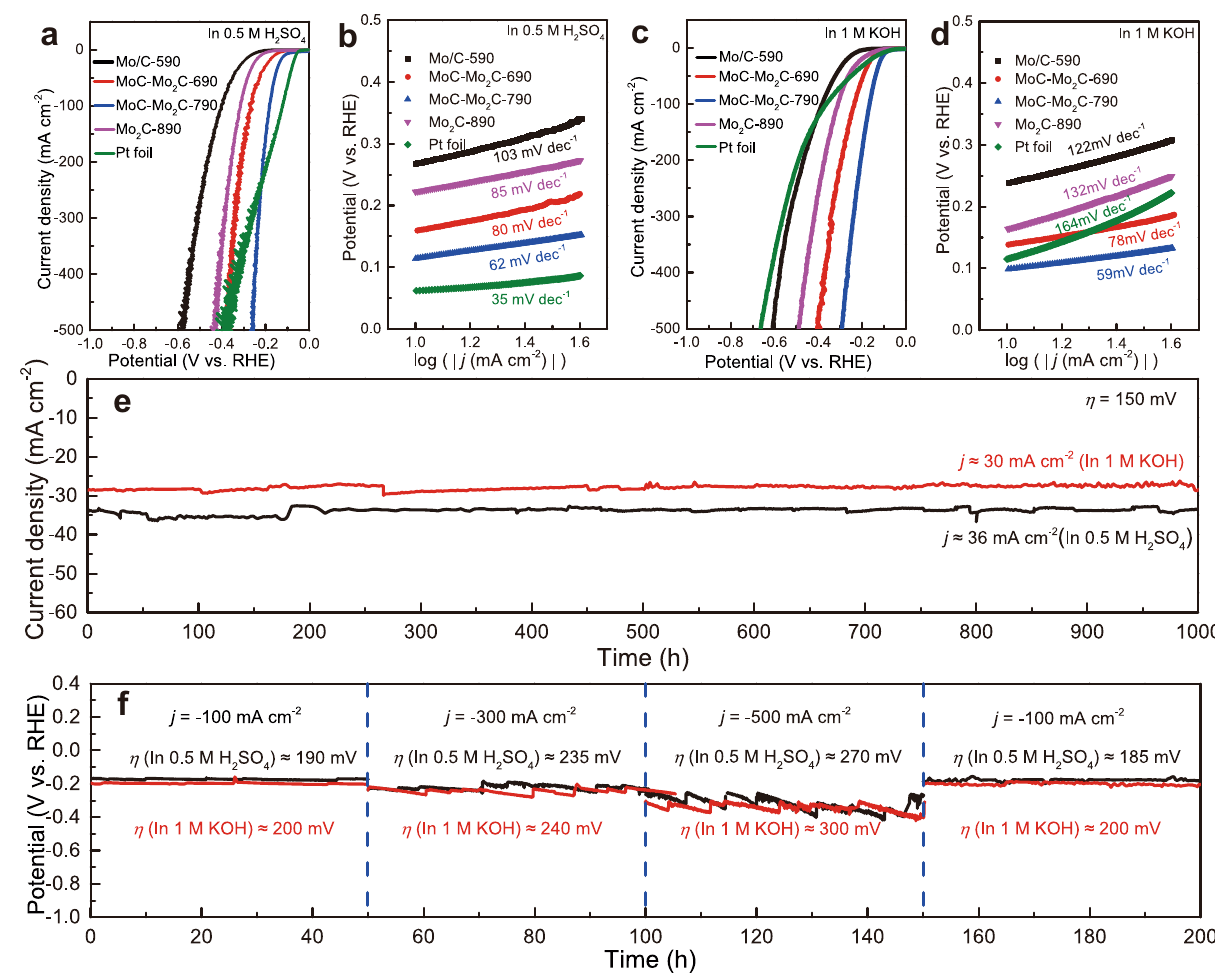
Fig. 2 HER performances of electrolytic electrodes in both acidic and alkaline solutions. a Polarization curves (with iR -correction) and b their corresponding Tafel plots of various electrodes in 0.5 M H 2 SO 4 . c Polarization curves (with iR -correction) and d corresponding Tafel plots of electrolytic electrodes in 1 M KOH. e The long-term electrolysis stability test of MoC – Mo 2 C-790 at η = 150 mV in 0.5 M H 2 SO 4 and 1 M KOH. f The stability test